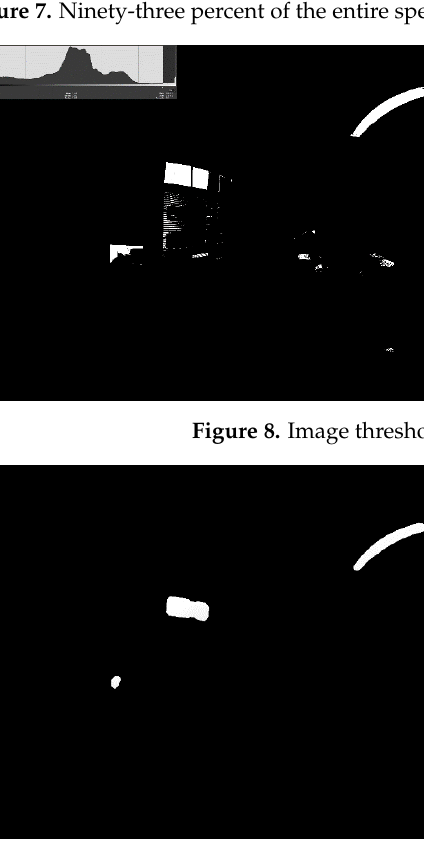
Figure 9. Median blur filter